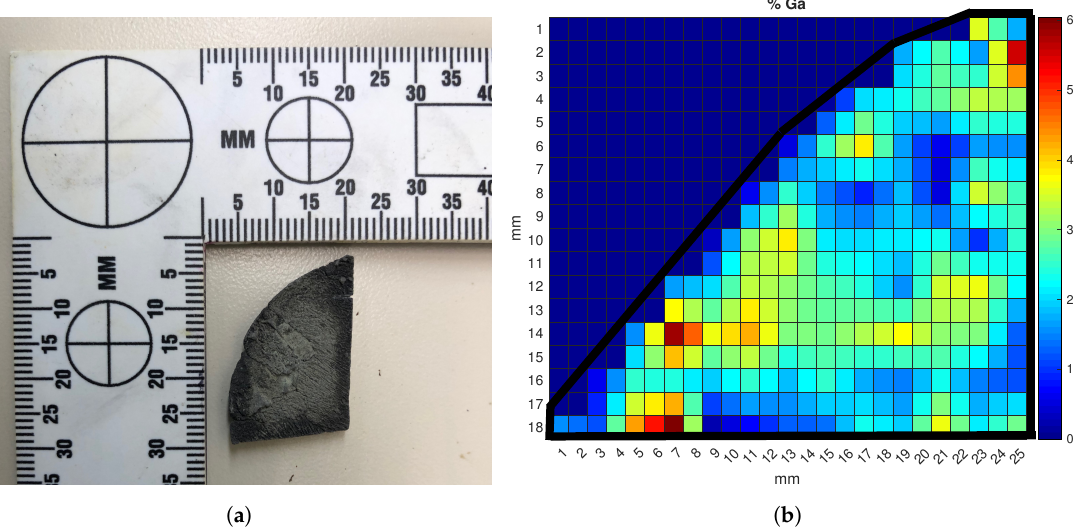
Figure 8. ( a ) Photograph of the 3% Ga cerium alloy sample used in the mapping analysis and ( b ) surface Ga concentration map of the sample. The color map represents the localized weight percent of gallium ranging from zero to six